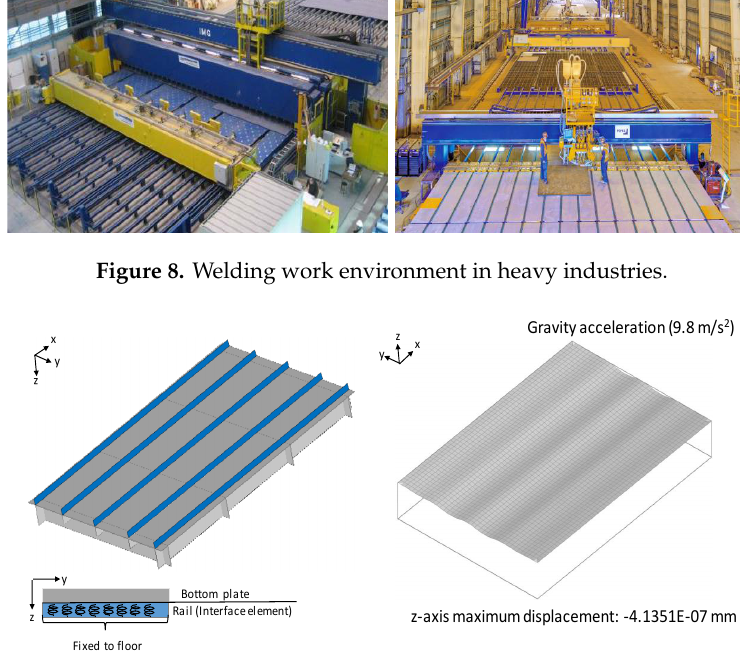
Figure 8. Welding work environment in heavy industries.